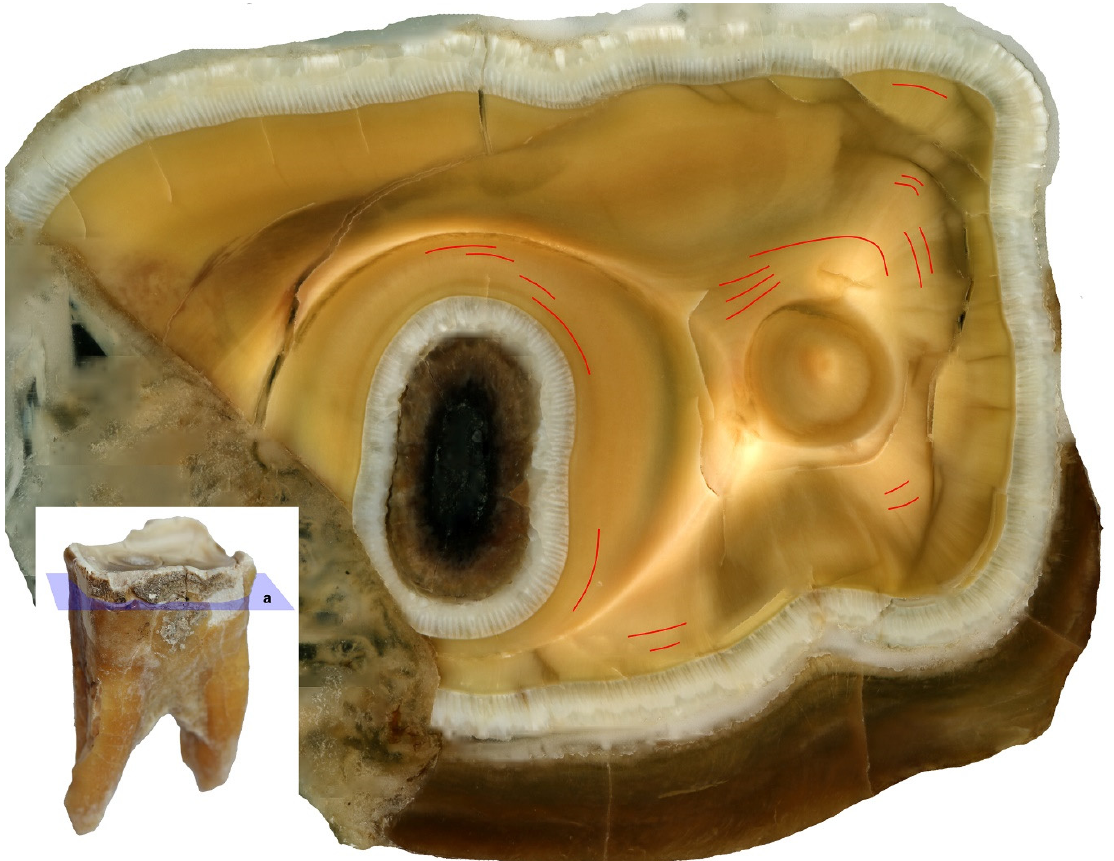
Figure 7. Dentine growth lines on the horizontal section through the tooth crown on the third premolar (P 3 ) of the white rhinoceros female, a : horizontal section through the tooth crown.